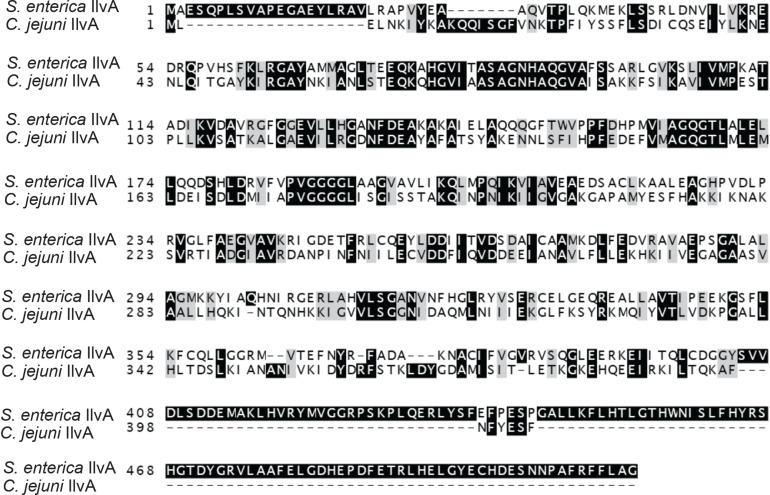
Campylobacter jejuni Cj0828 is an IlvA homolog. Salmonella enterica IlvA and Campylobacter jejuni Cj0828 protein sequences share 32% identity. Cj0828 (cjIlvA) lacks the C-terminal domain that contain the site of allosteric regulation by isoleucine.